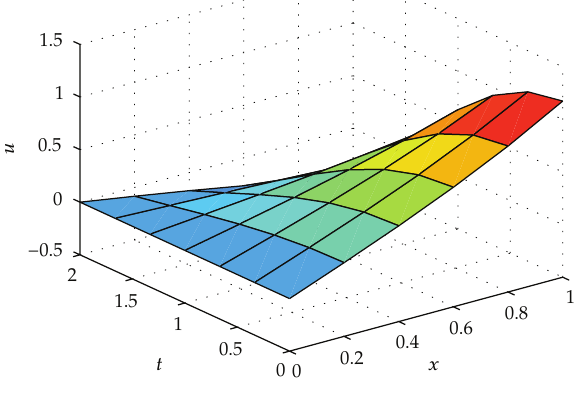
Figure 5: Exact solution.